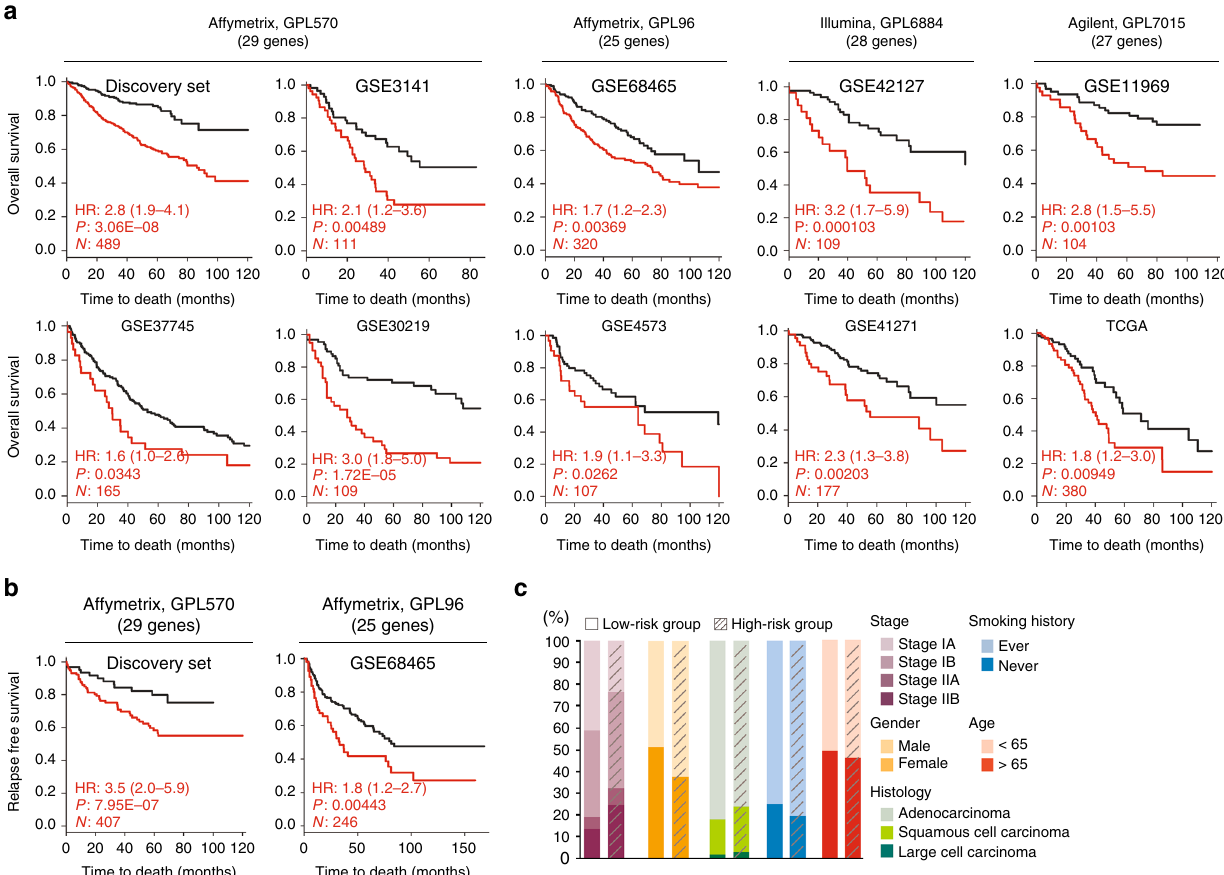
Fig. 4 Prognostic value of the EPPI gene signature. The EPPI risk score strati fi ed patients into two groups based on optimal cutoff score in each data set with signi fi cantly different a overall survival (OS); and b relapse free survival (RFS). The adjusted hazard ratio (HR), log-rank p -value ( P ), and the number of patients successfully strati fi ed ( N ) determined from univariate Cox regression analyses are shown on each survival KM curve. Black and red KM curves represent predicted low-risk and high-risk group, respectively. c Bar graph comparing the number of patient for other clinical prognostic variables between high-and low-risk a best prognostic accuracy in predicting survival post surgery.